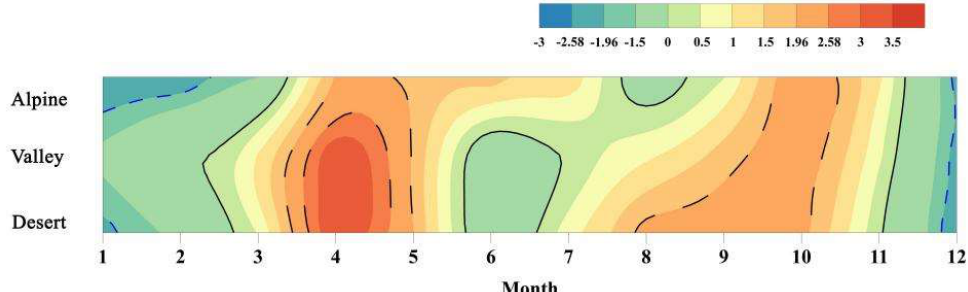
Figure 5. Trend test results of monthly NDVI. Note: the solid line is the border of the time horizon indicating an increasing ( Z C > 0) and decreasing ( Z C < 0) trend. Further, the dotted line is the border of the time horizon representing the significant increase ( Z C > 1.96, p < 0.05) (including the extremely significant increasing trend ( Z C > 2.58, p < 0.01)) and the non-significant increasing trend (| Z C | < 1.96, p < 0.05).